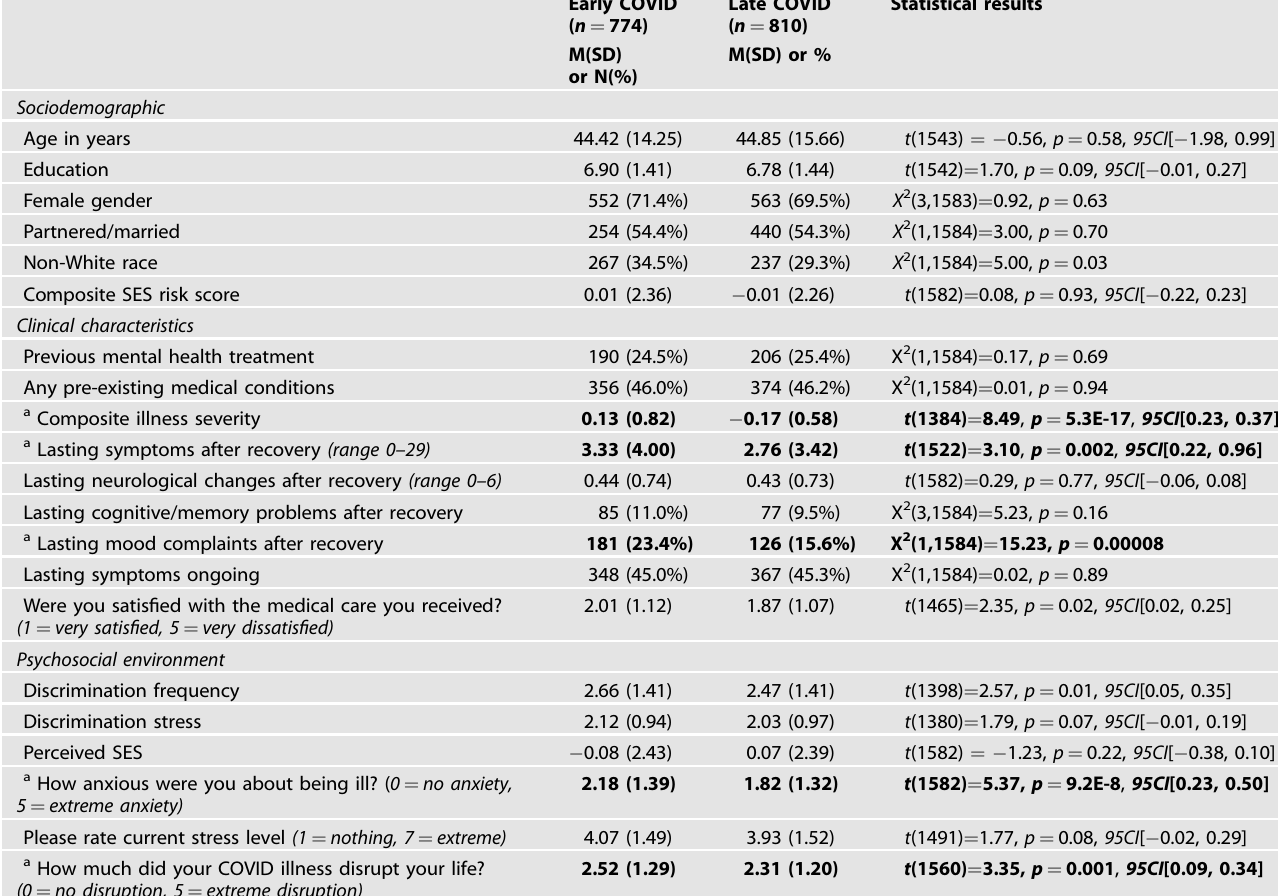
Table 1. Sociodemographic and illness characteristics in patients infected early or late in the